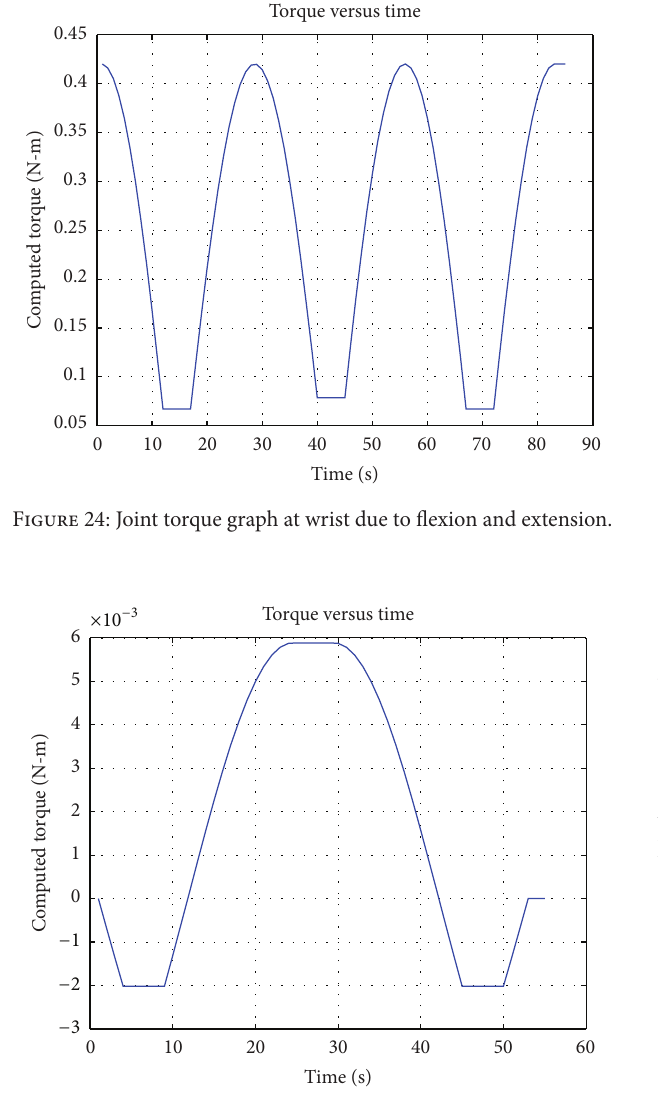
Figure 25: Joint torque graph at elbow due to shoulder internal and external rotation.